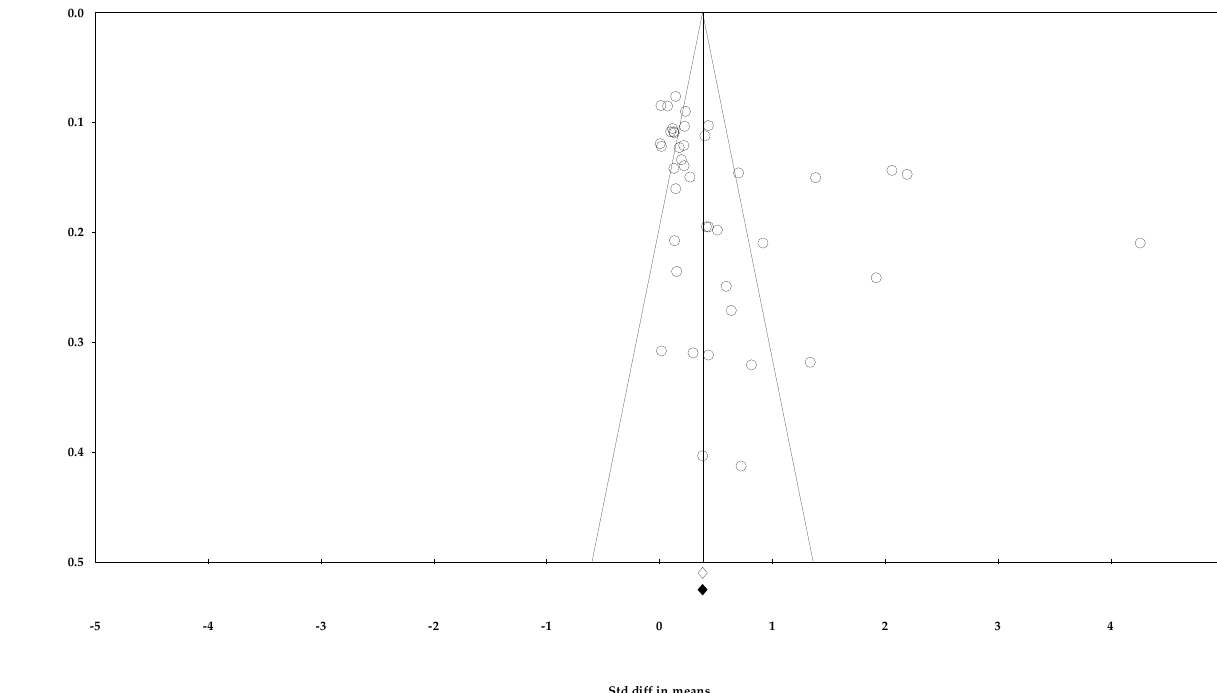
Figure 2. A funnel plot of the standardized mean difference in systolic blood pressure. Note: summary effect size ( ◇ ), summary effect size of imputed studies ( ◆ ), individual study ( ○ ).